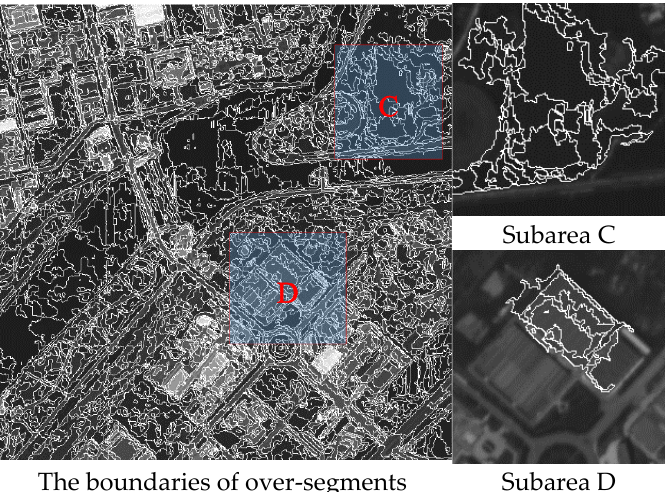
Figure 7. The boundaries of over-segments obtained by using the ddCRP_1 from the TIANHUI image. Both subareas C and D coupled with over-segments are shown in the two right-side subfigures.